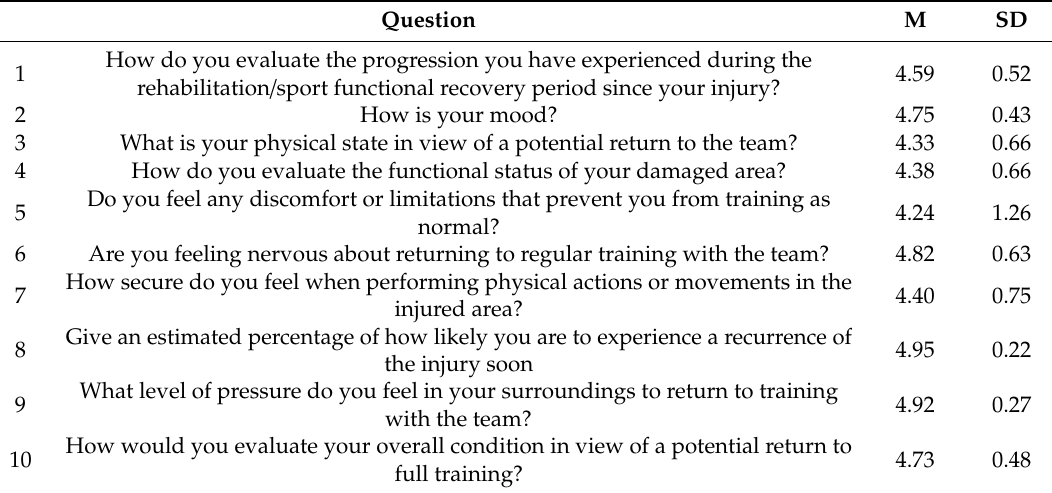
Table 2. Average and typical deviation of each of the questionnaire questions.